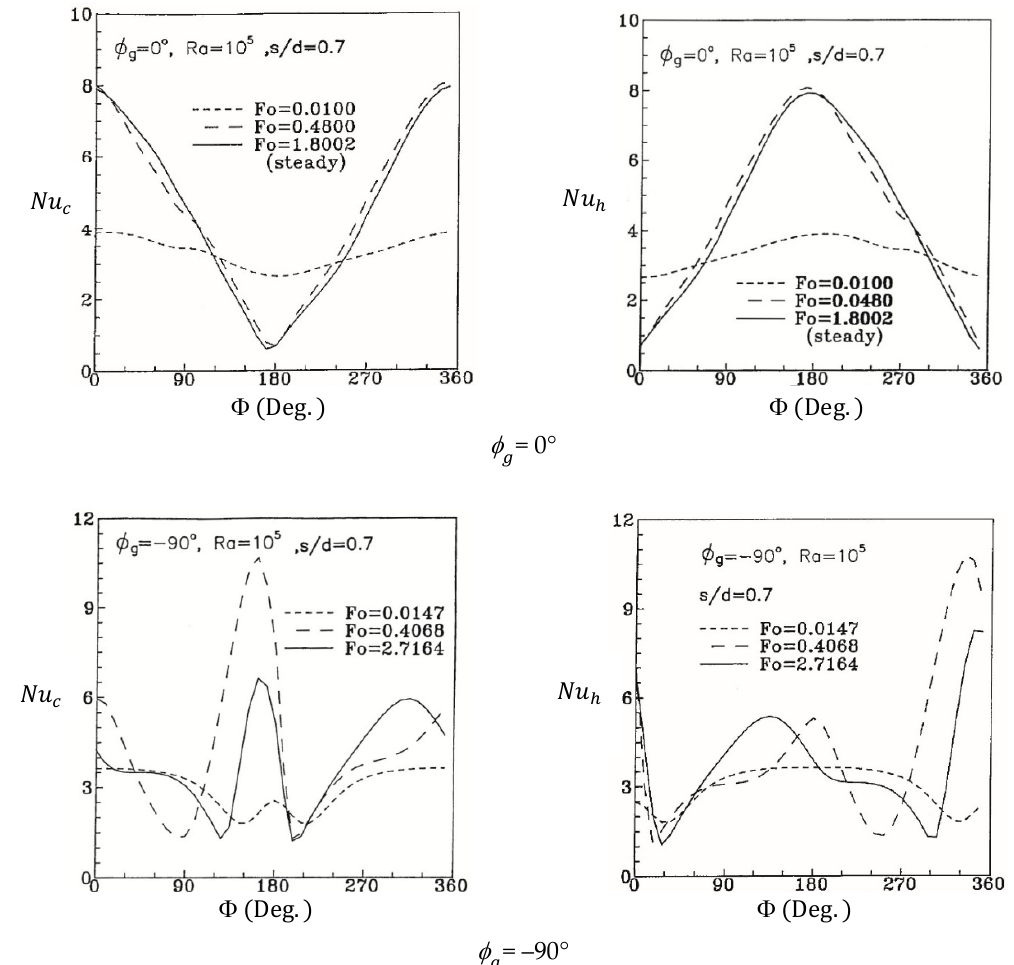
Figure 9. Variation in the local heat transfer coefficients of the cold cylinder ( left ) and hot cylinder ( right ) versus time ( Ra = 10 5 and s/d = 0.7).